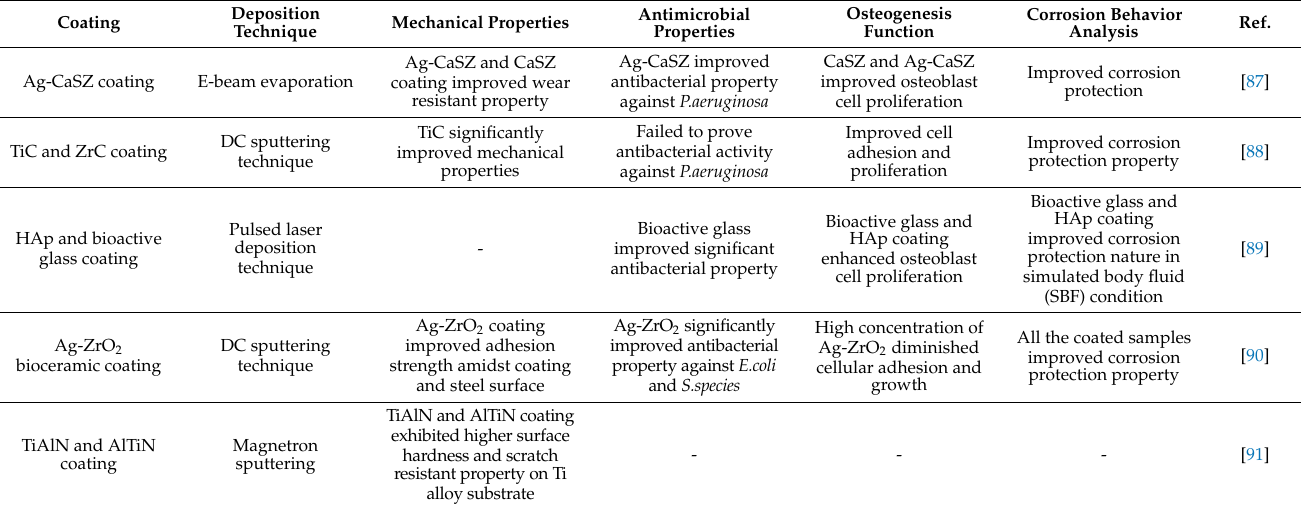
Table 1. Multifunctional coatings and its mechanical, antibacterial and biological